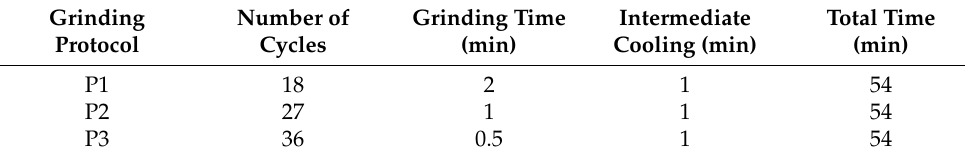
Table 1. Grinding protocols varying number of cycles and grinding time.